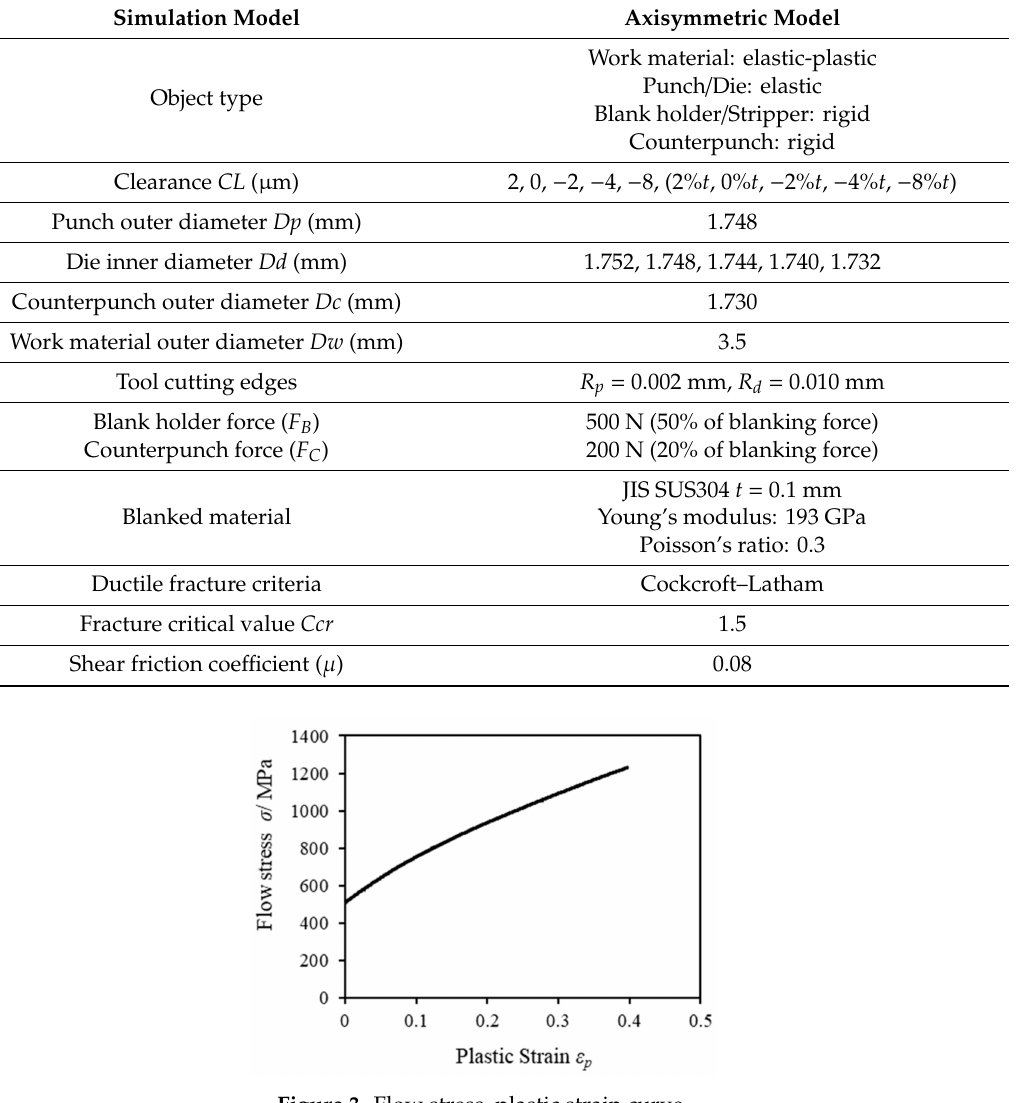
Figure 3. Flow stress–plastic strain